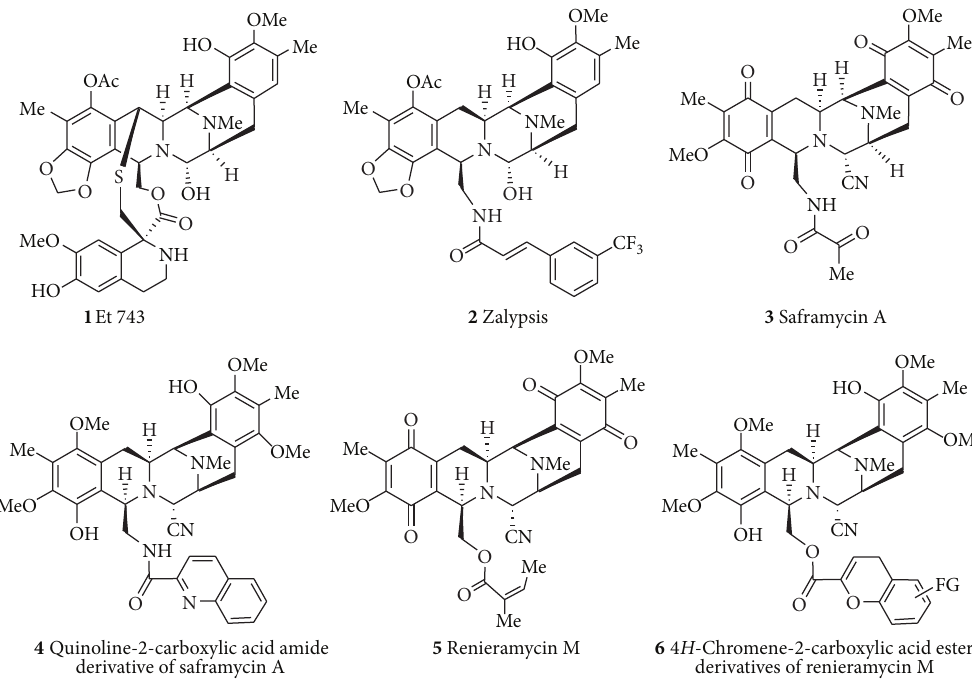
Figure 1: Structures of tetrahydroisoquinoline compounds.